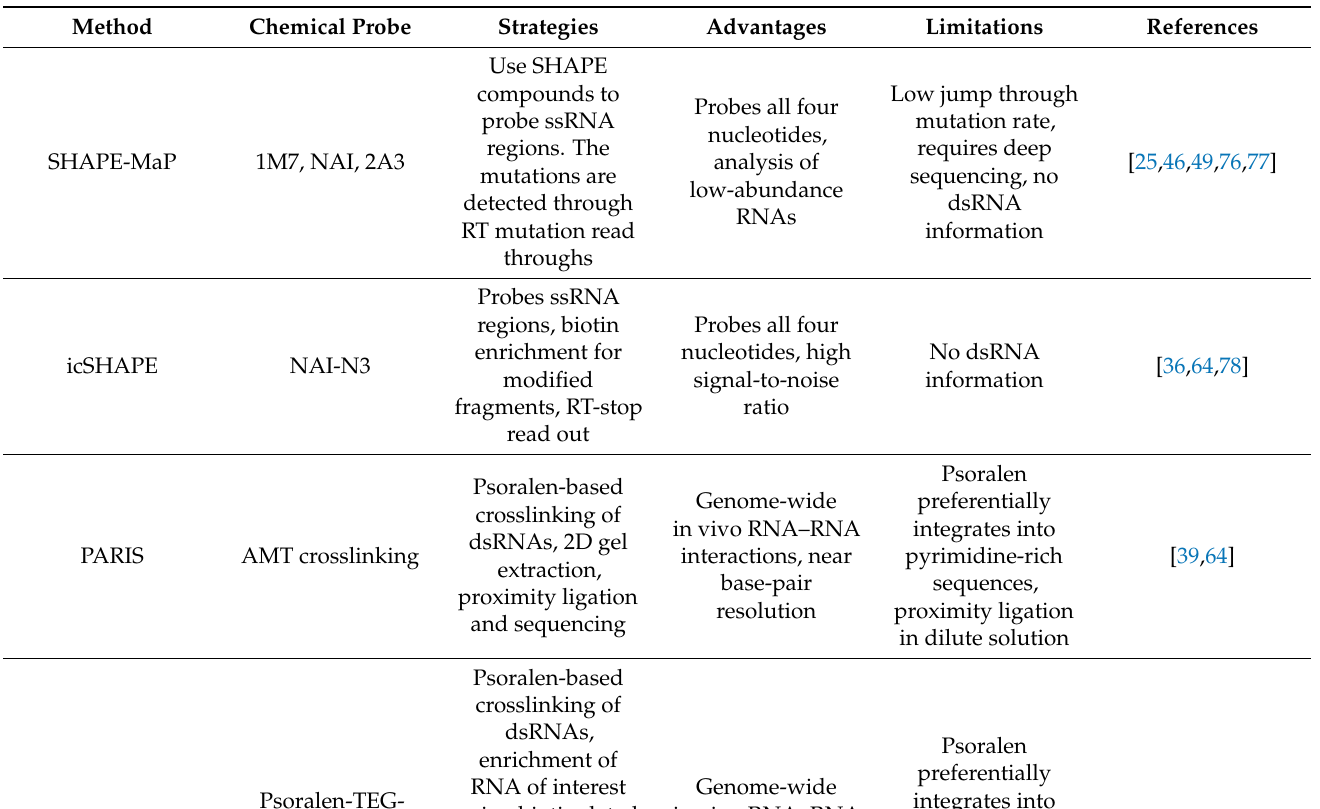
Table 2. High-throughput global mapping strategies for RNA secondary structures and tertiary